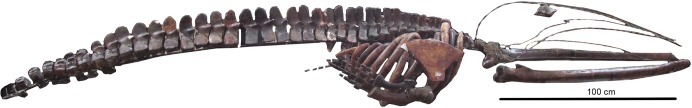
The skeleton of Otradnocetus sp., VSEGEI 2401, from the Middle Miocene of the northwestern Caucasus (Russia), right lateral view.The scale bar equals one m. Courtesy of Grigory Prokopov.